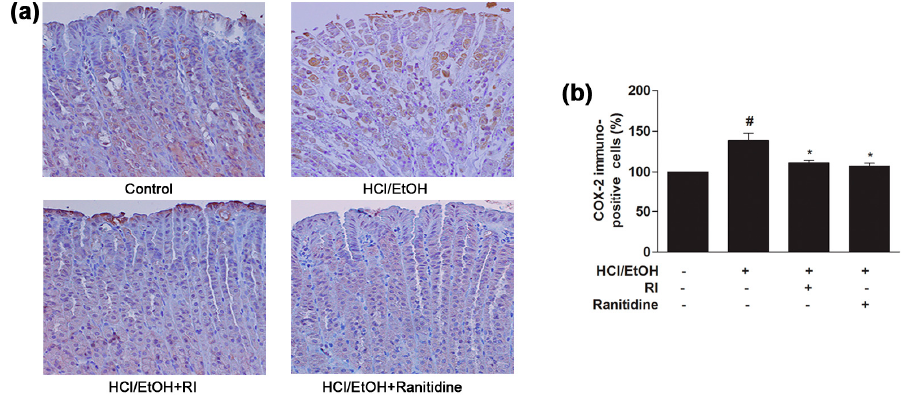
Figure 5. Protective role of RI on COX-2 immunoreactivity in the gastric tissue: ( a ) COX-2 expression in gastric mucosal epithelial cells; and ( b ) COX-2 positive immune-stained cells. Scale bar, 200 µm. # p < 0.05 when compared with the control and * p < 0.05 when compared with HCl/EtOH. Data are expressed as mean ± SEM.